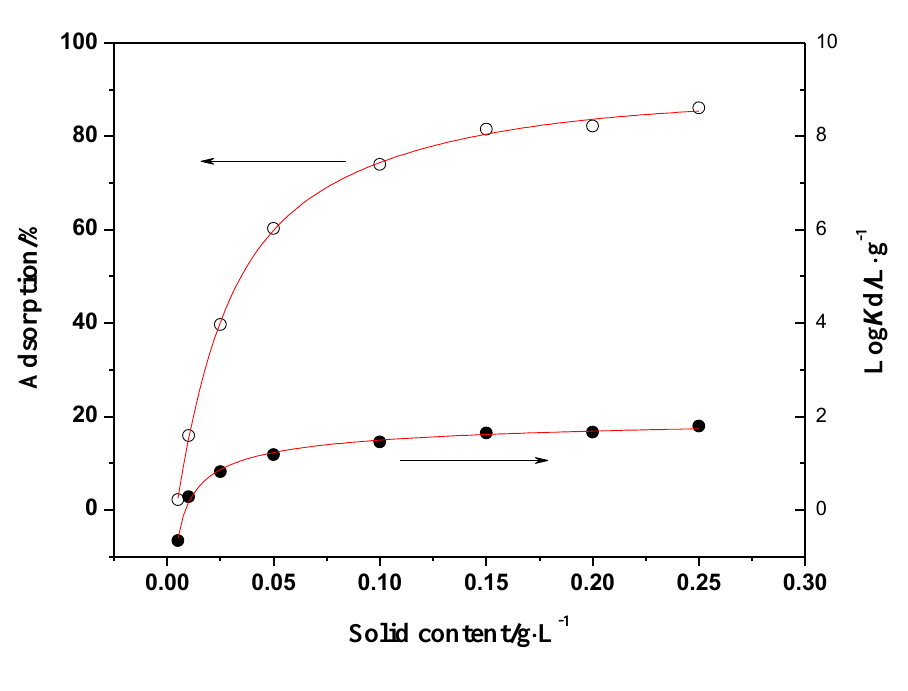
Figure 6. Effect of solid content on the adsorption of Th(IV) onto oMWCNTs, pH = 3.20 ± 0.05, T = 25 ± 1 °C, C[Th 4+ ] initial = 8.86 × 10 −5 mol/L, I = 0.01 mol/L NaNO 3